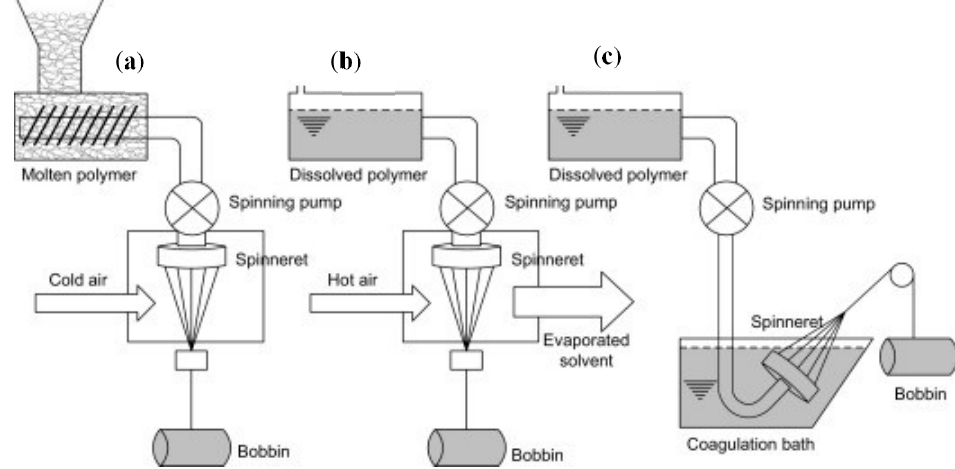
Figure 6. Spinning processes: ( a ) melt-spinning, ( b ) dry-spinning, and ( c ) wet-spinning (redrawn based on [172].